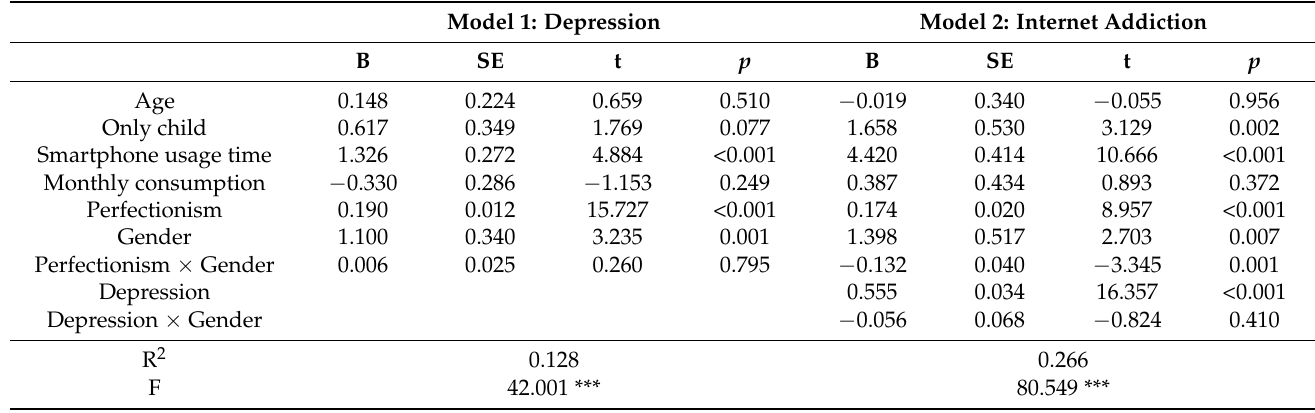
Table 5. Result of moderated mediation analysis.